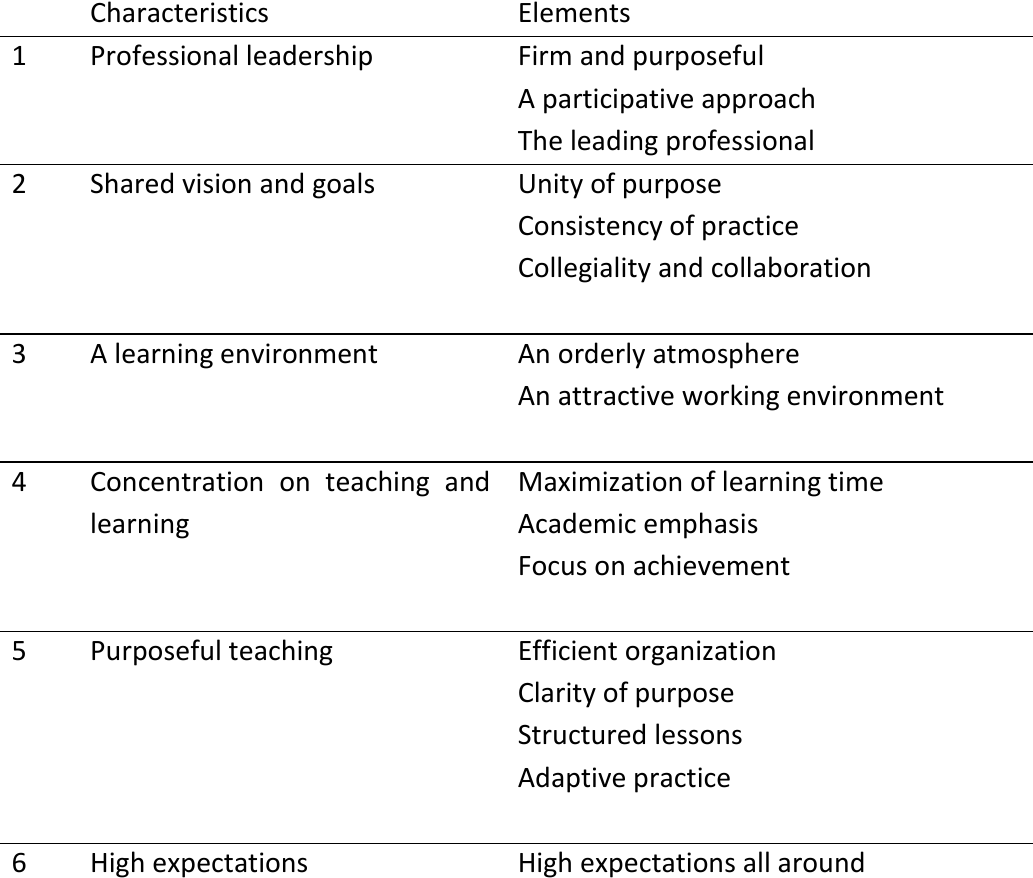
Eleven Characteristics Found in Effective Schools Resulting From a Review of International School Effectiveness